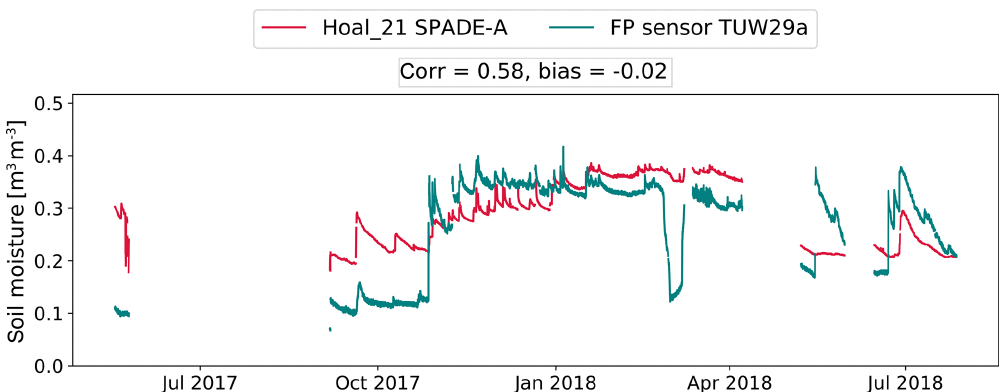
Figure A4. Soil moisture time series of FP sensor TUW29a and professional probe Hoal_21 at a depth of 0.05m, installed next to each other.